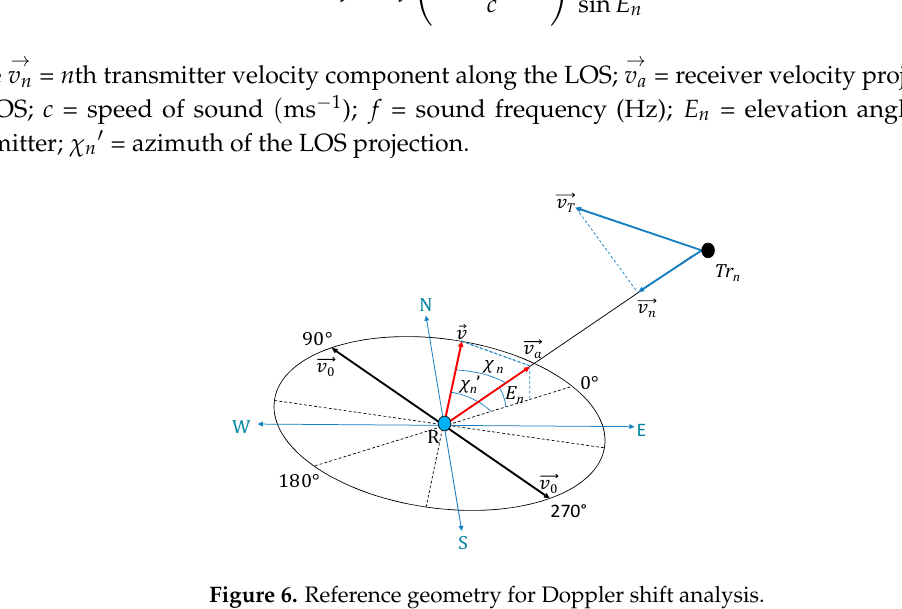
Figure 6. Reference geometry for Doppler shift analysis.